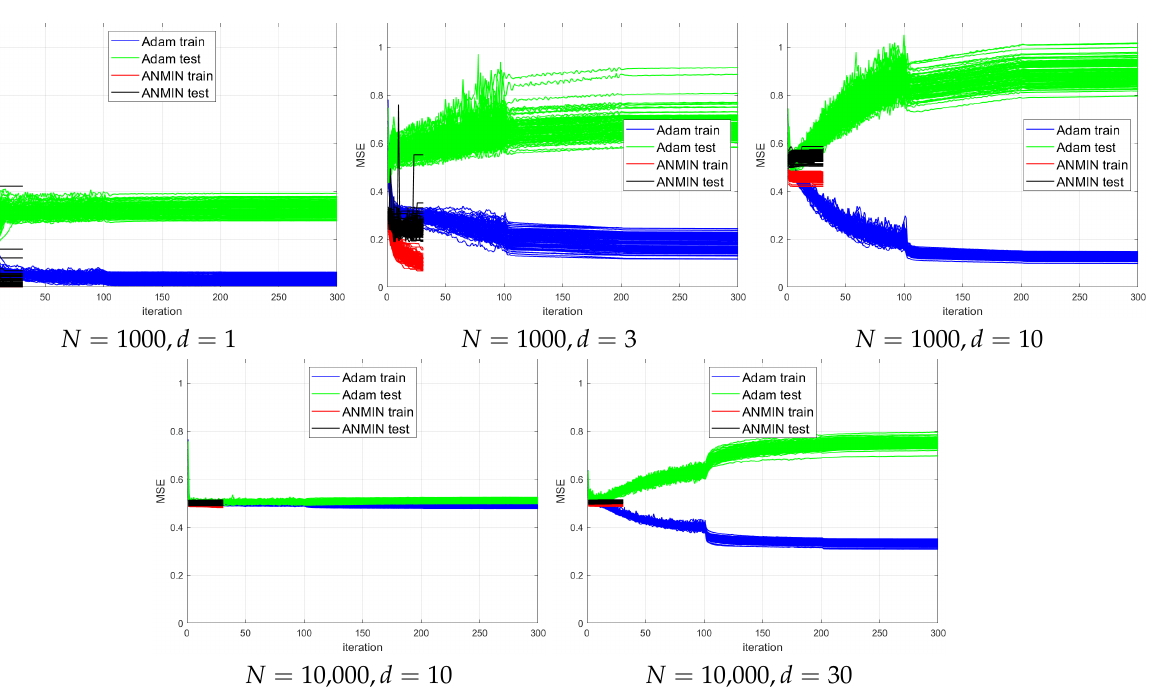
Figure 7. Simulation experiments. MSEs of 100 runs of training a 64 hidden node NN using 300 epochs of the Adam optimizer or 30 iterations of ANMIN (Algorithm